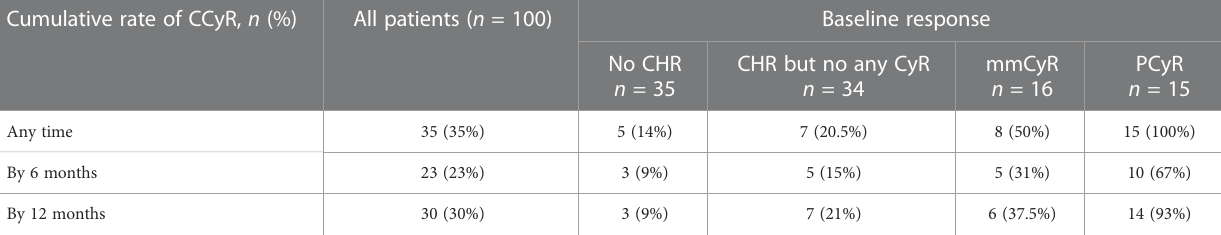
TABLE 2 The cumulative rate of CCyR in patients undergoing third-line TKI therapy. Cumulative rate of CCyR, n (%)